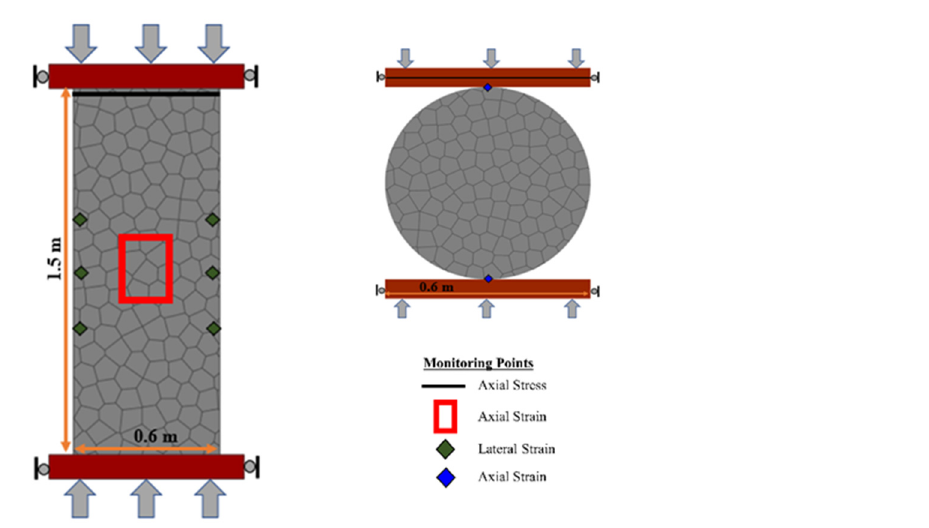
Figure 6. Geometry, boundary conditions, and monitoring locations of the UCS and indirect tensile strength tests.